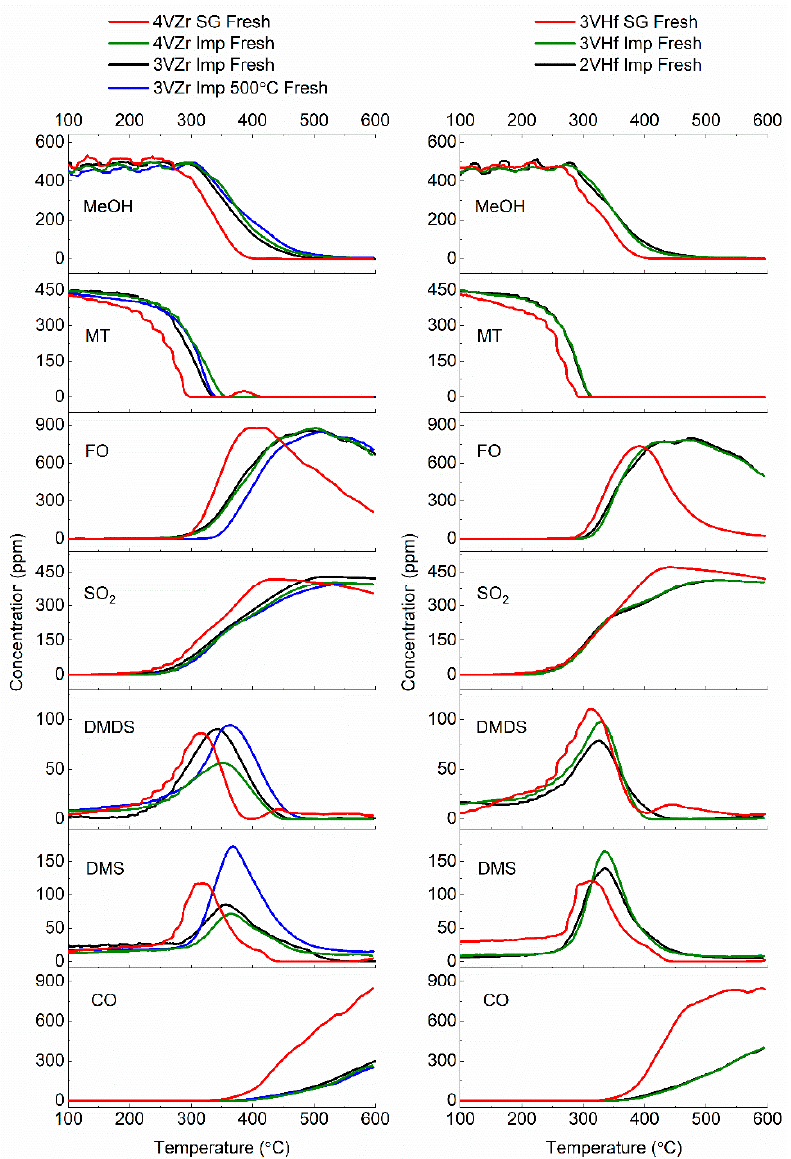
Figure 5. Formaldehyde (FO) production from methanol (MeOH) and methanethiol (MT) over the studied fresh catalysts; consumption of reactants and formation of different reaction products.